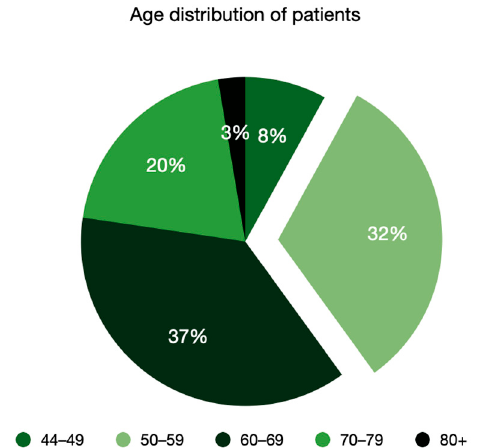
Figure 1. Age distribution.